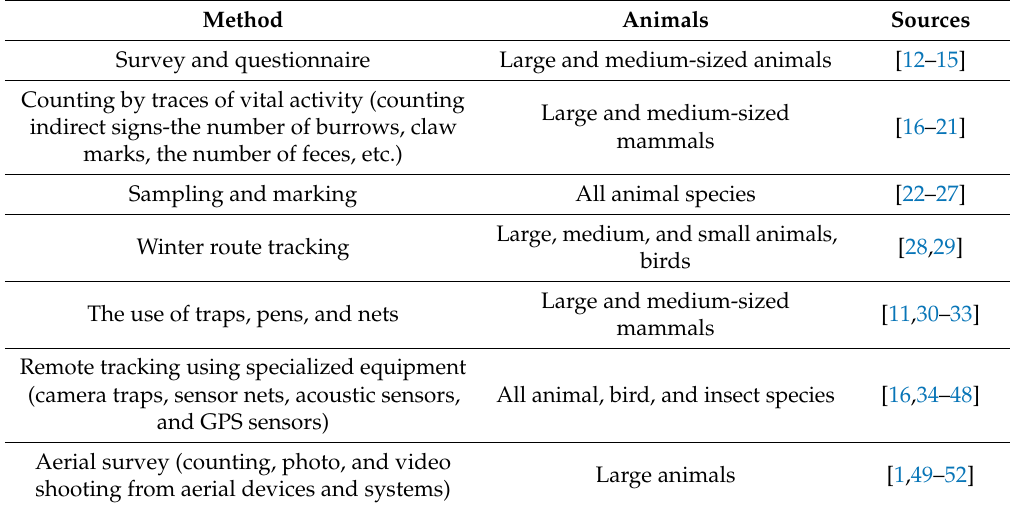
Table 1. Traditional wildlife monitoring